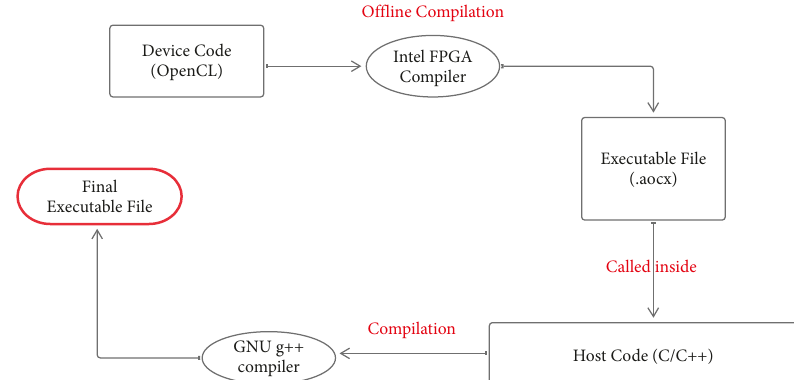
Figure 1: OpenCL project compilation process.